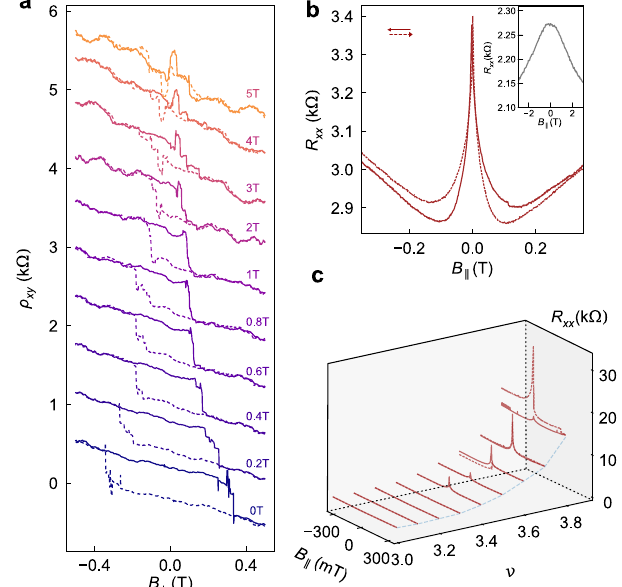
Fig. 3 | Anisotropic magnetoresistance.a Hysteresis in ρ xy ( B ⊥ ) for fi xed in-plane magnetic fi elds ( B ∥ ) up to 5 T. The curves are offset by 600 Ω for clarity (D2, ν =3.57, D = − 0.43V/nm, T =100mK). b A sharp peak in R xx ( B ∥ ) is observed at B ∥ =0 throughout the AHE region. The slight offset in R xx , comparing up and down traces away from B =0, is caused by additional heating of the sample when sweeping the magnet away from zero fi eld. Inset: fi ner scan just over the peak illustrates rounding on the B ∥ =1mT fi eld scale (D1, ν =3.43, D = − 0.42V/nm, T =100mK). c Evolution of the R xx ( B ∥ ) magnetoresistance with ν . The peak appears immediately upon entering the AHE region ( ν ≳ 3.4). Difference between up and down traces illustrates irreproducibility of B ∥ sweeps at low fi eld (D2, D = − 0.43V/nm, T =300mK, B ⊥